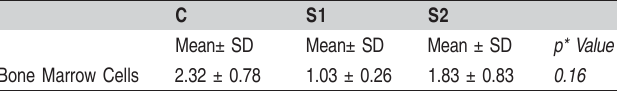
Table 2 - Cell adhesion between the three groups: control (C), polished (S1) and cathodic cage plasma nitrided (S2) Ti surfaces.